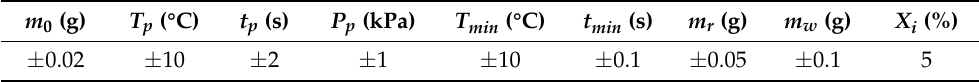
Table 1. Measurement